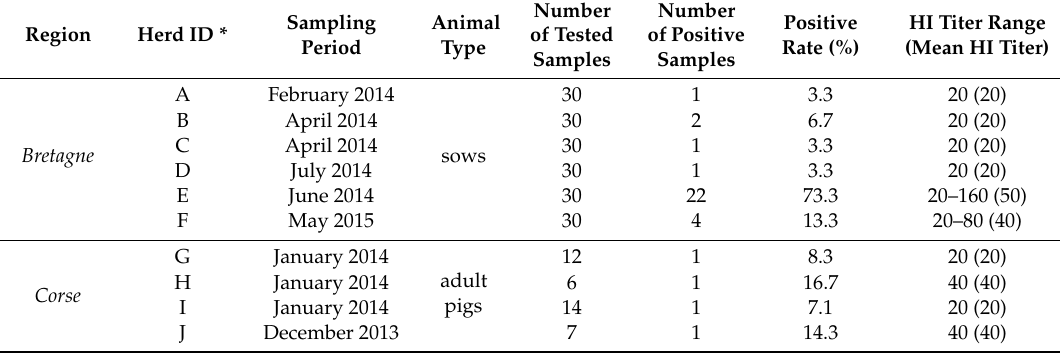
Origins of domestic pig sera that gave positive results in swine influenza D virus hemaglutination inhibition (HI)